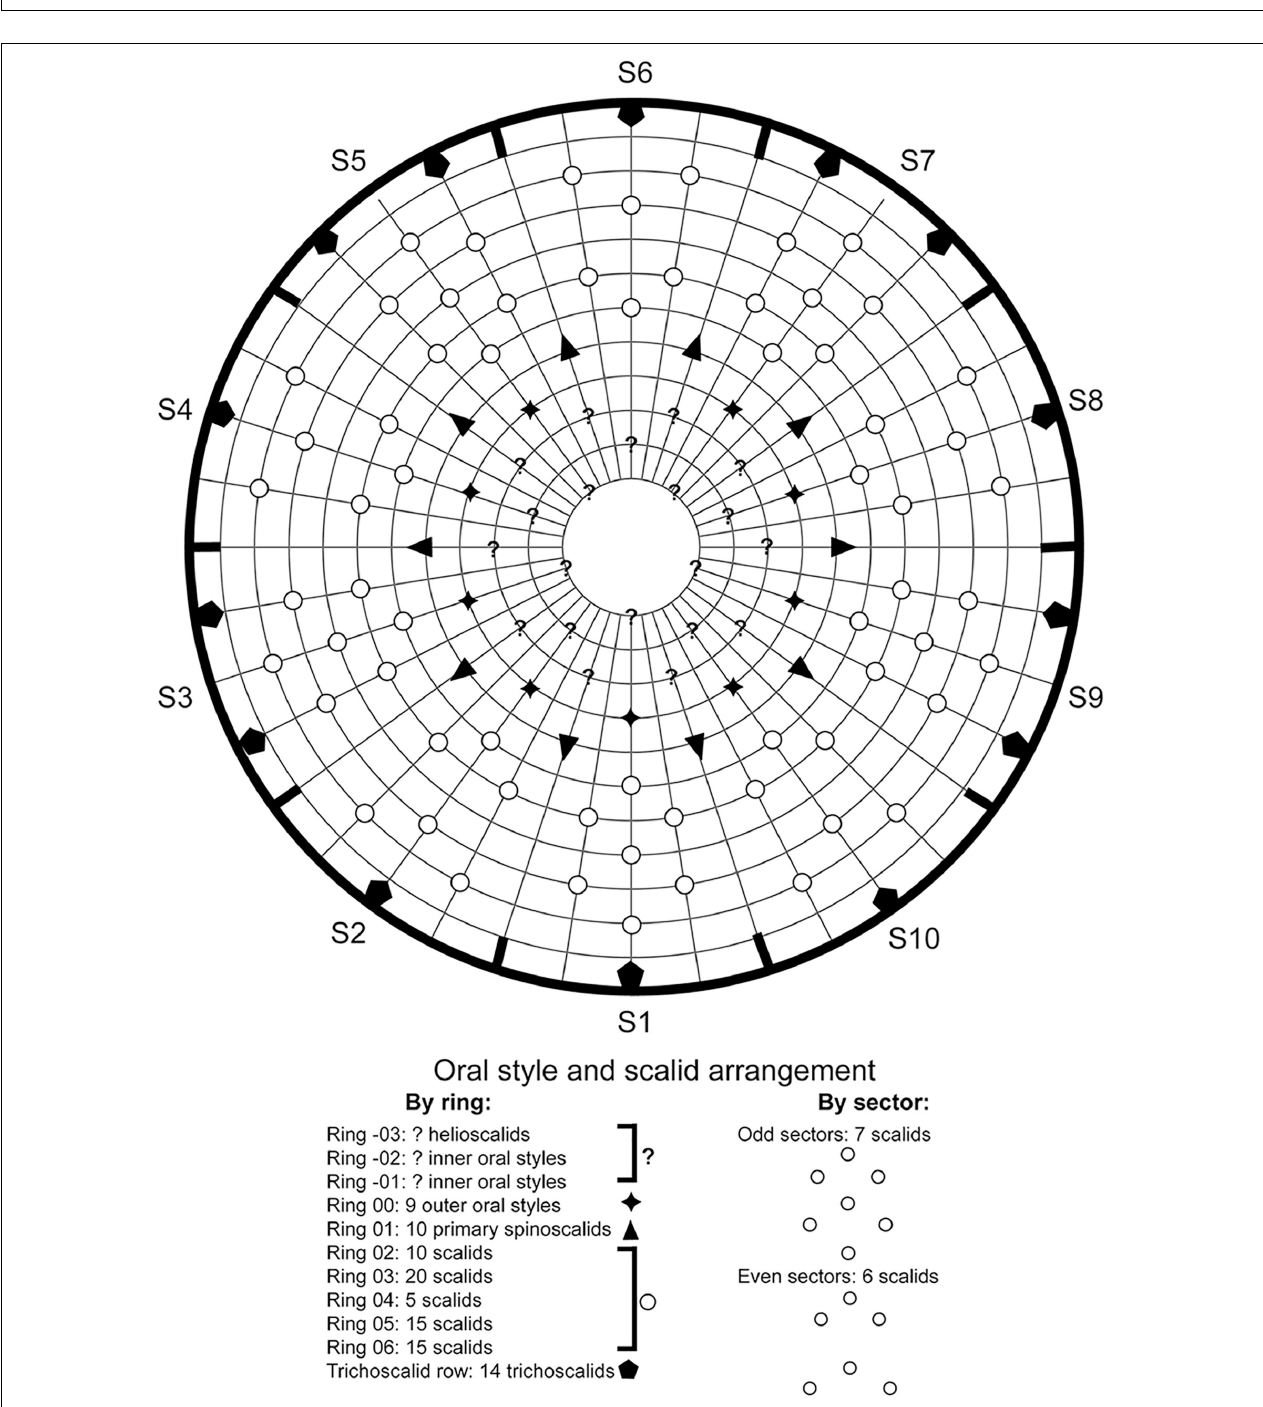
FIGURE 1 | Line art illustrations of Fujuriphyes dagon sp. nov. (A) Female, ventral view; (B) female, dorsal view; (C) male, segments 1–2, ventral view; (D) male, segments 10–11, ventral view. Scale bar: 250 µ m. Abbreviations: ap, apodeme; dcr, dorsal cuticular ridge; dpl, dorsal placid; gco, glandular cell outlet; ldse, laterodorsal seta; ldss, laterodorsal sensory spot; ldss3, laterodorsal type 3 sensory spot; lts, lateral terminal spine; lvse, lateroventral seta; ms, muscular scar; pdse, paradorsal seta; ppf, primary pectinate fringe; ps, penile spine; sdgco, subdorsal glandular cell outlet; sdss, subdorsal sensory spot; spf, secondary pectinate fringe; vcr, ventral cuticular ridge; vlse, ventrolateral seta; vlss, ventrolateral sensory spot; vmgco, ventromedial glandular cell outlet; vmss, ventromedial sensory spot; vmt, ventromedial tube; vpl, ventral placid.